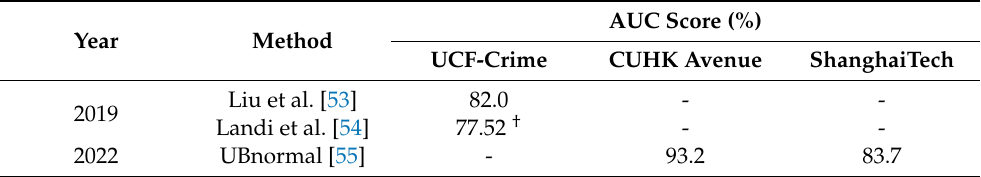
Table 3. FramelevelAUCscoresofseveralfullysupervisedmethods, benchmarkedonCUHKAvenue[11], ShanghaiTech Campus [4] and UCF-Crime [40] datasets. Results compiled by Feng et al. [39]. Legend: